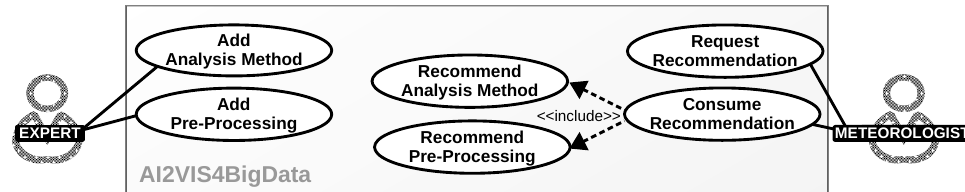
Figure 7. Expert and Meteorological End User Use